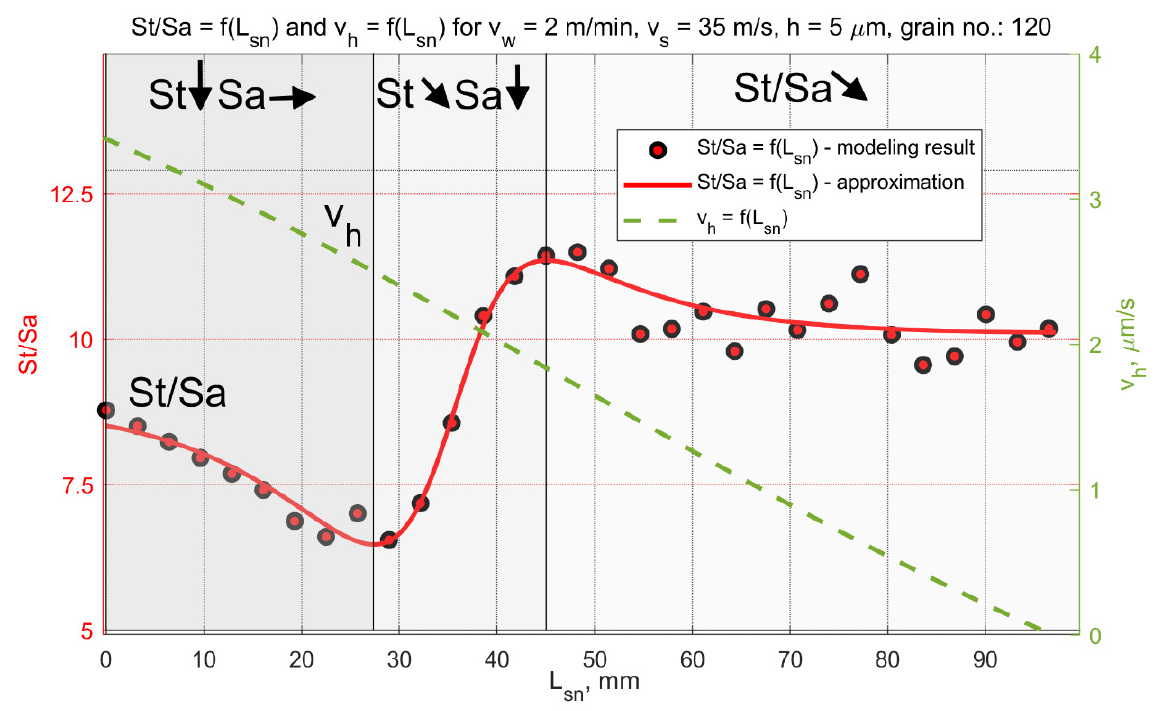
Figure 16. Changes in the ratio St / Sa as a function of the grinding path for a grinding depth of h = 5 µm.